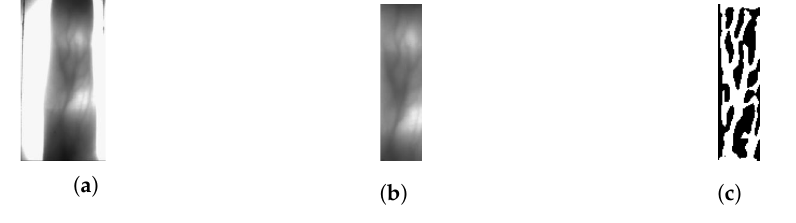
Figure 7. The preprocessing results. ( a ) original finger-vein images samples from HKPU. database; ( b ) ROI extracted from ( a ); ( c ) vein feature segmented from ( b ).